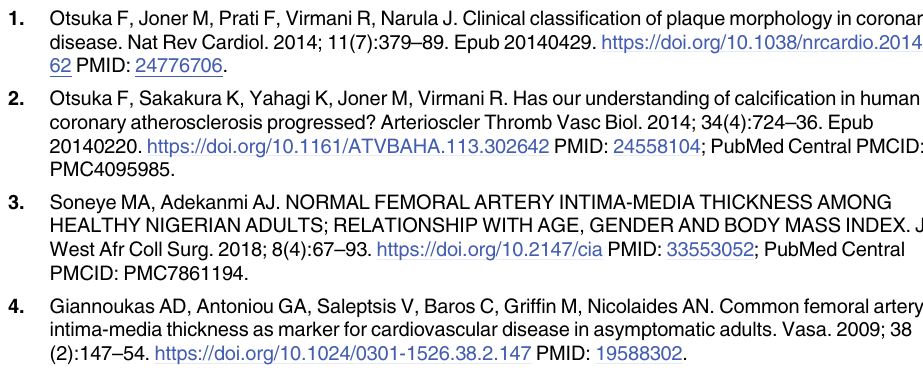
S1 Table. Patient characteristics. S2 Table. The comparison of luminal narrowing and plaque type between main and side branches. S3 Table. The comparison of luminal narrowing and plaque type between proximal, mid, and distal left anterior descending arteries. S4 Table. The comparison of luminal narrowing and plaque type between proximal, mid, and distal left circumflex arteries. S5 Table. The comparison of luminal narrowing and plaque type between proximal, mid, and distal right coronary arteries. S1 Fig. The comparison of the tapered ratio of the main branches.